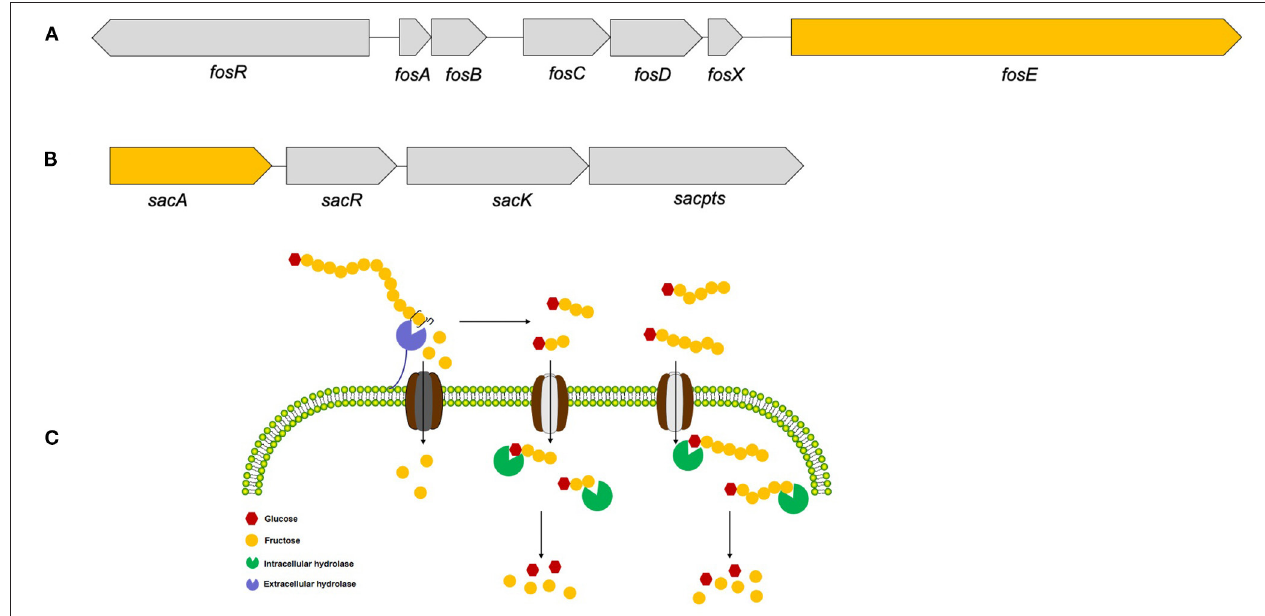
FIGURE 6 | The two gene clusters predicted to link to inulin consumption (A,B) and the proposed metabolic routes of inulin (C) by L. paracasei